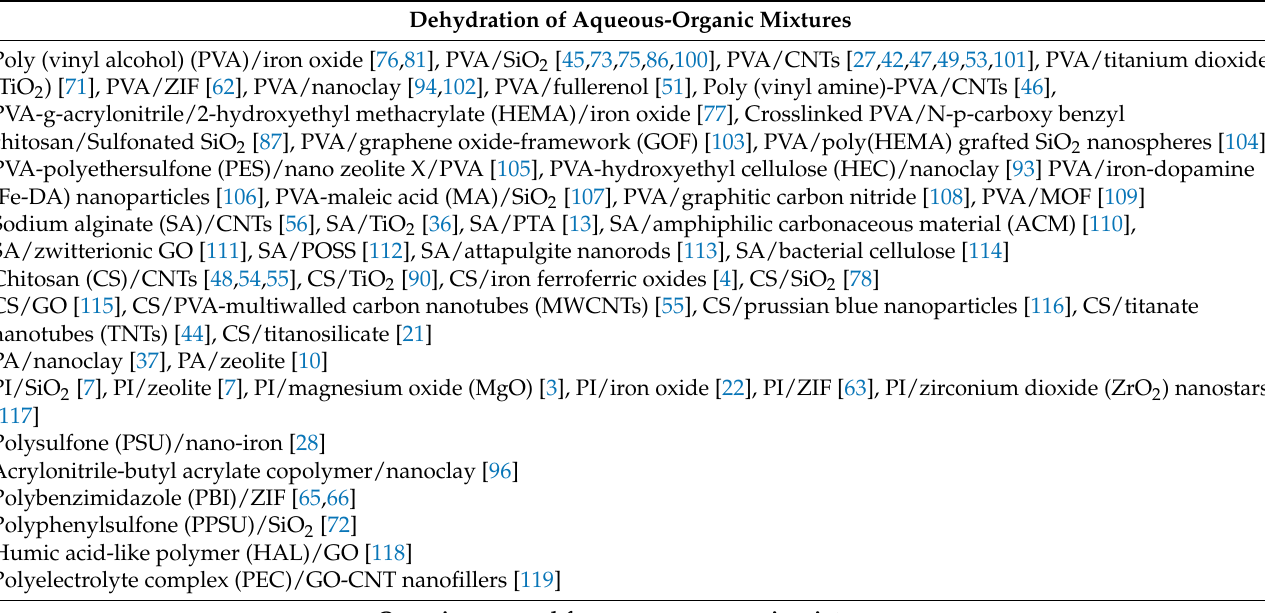
Table 1. PV nanocomposite membranes used in different